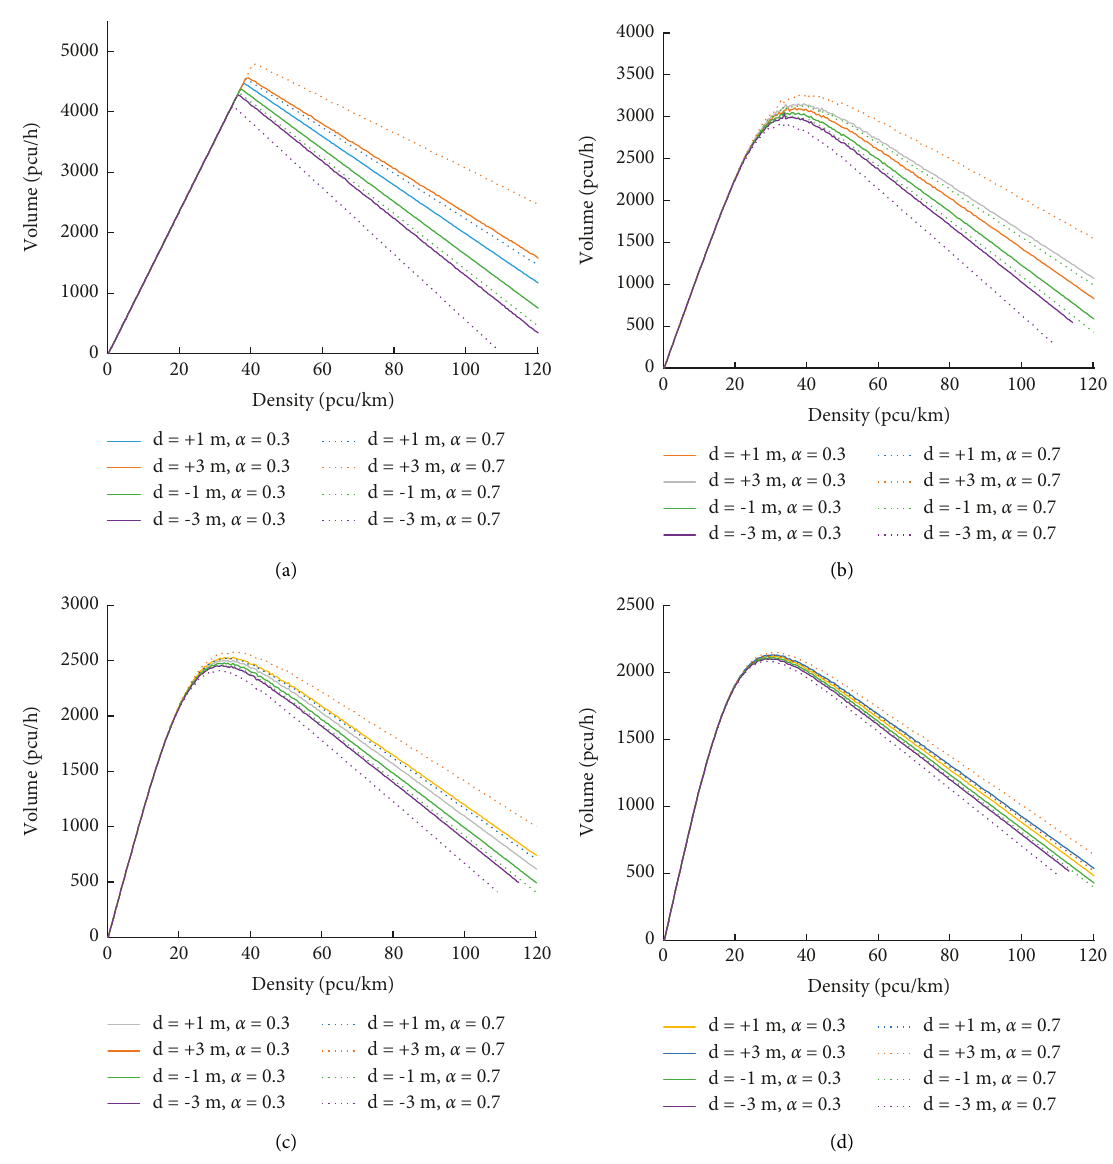
Figure 13: Traffic capacity with multiple bogus messages. (a) No HDV. (b) 25% HDVs. (c) 50% HDVs. (d) 75%